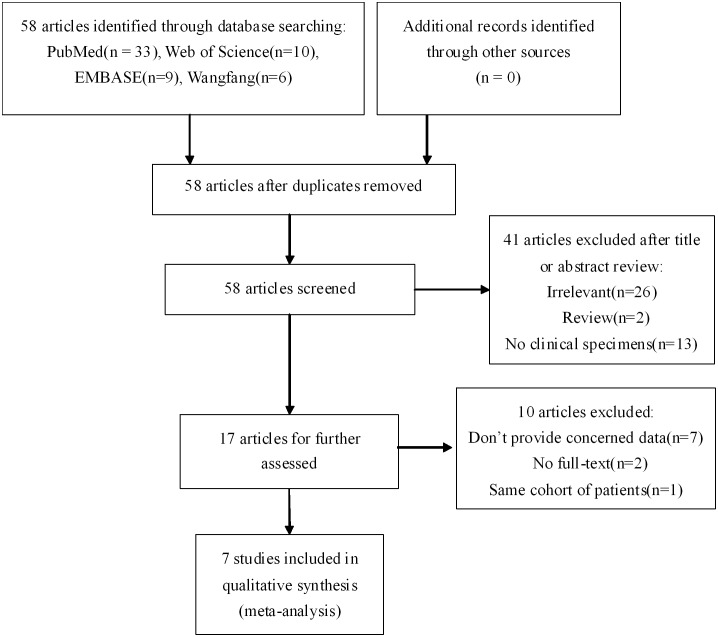
Flow diagram showing the study selection procedure.